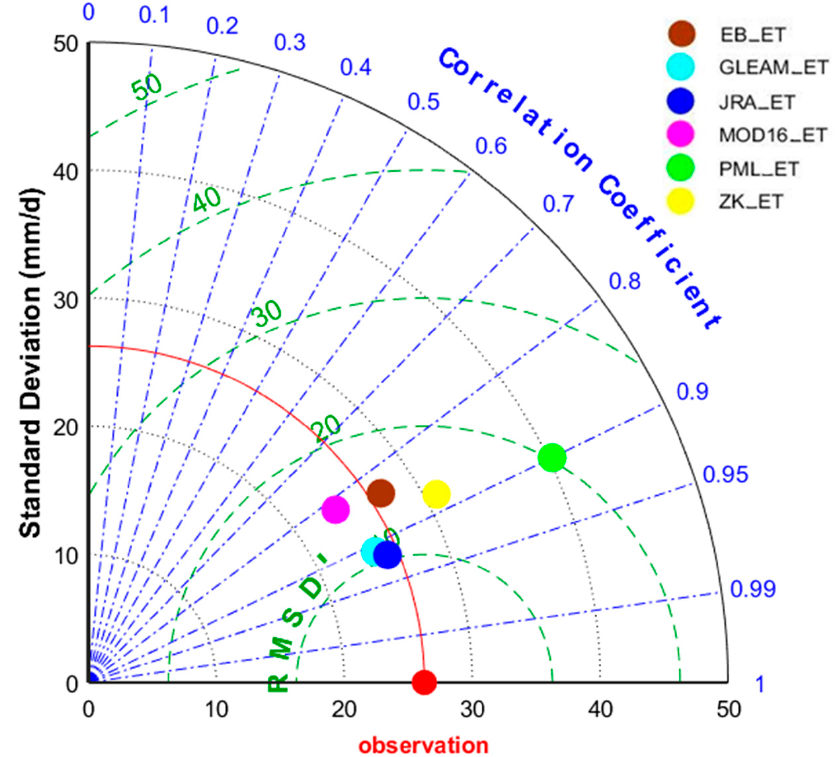
Figure 9. Monthly ET products for 2003–2012, validated at the basin scale using the water balance—as shown in the Taylor diagram. The units of the STD and RMSD’ are mm/month.